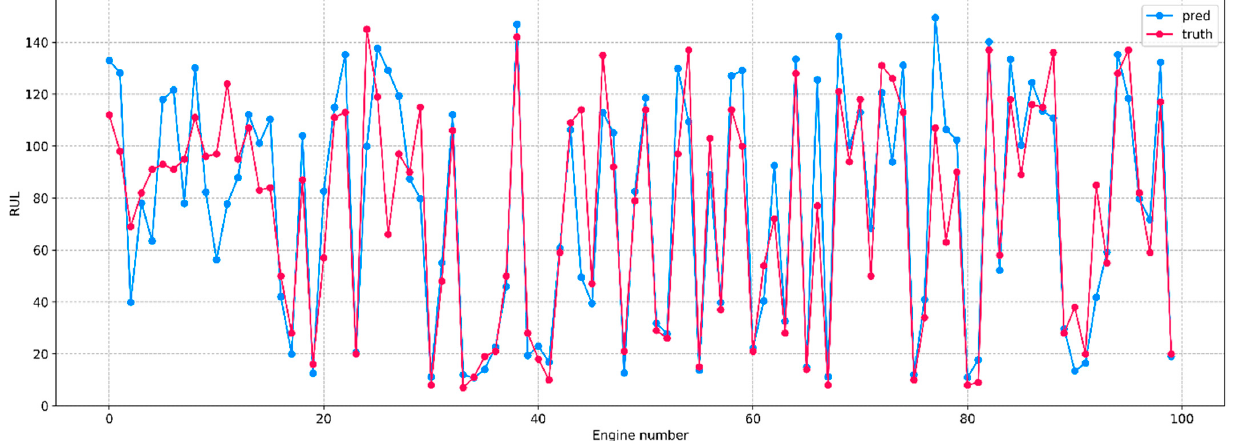
Figure 3. Predicted (blue) and true (red) engine RUL values. Table 3 shows a comparison of the RUL